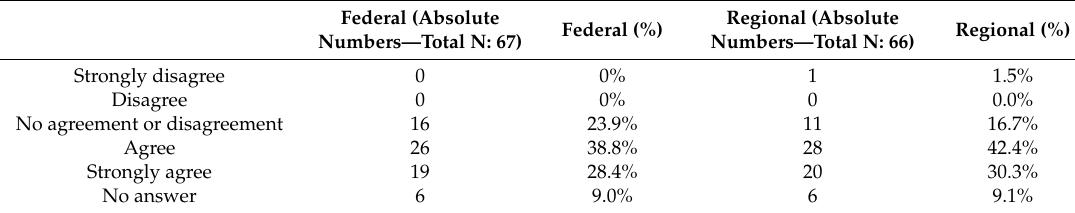
Table 5. Willingness to engage in more active future collaboration within the same governmental level.